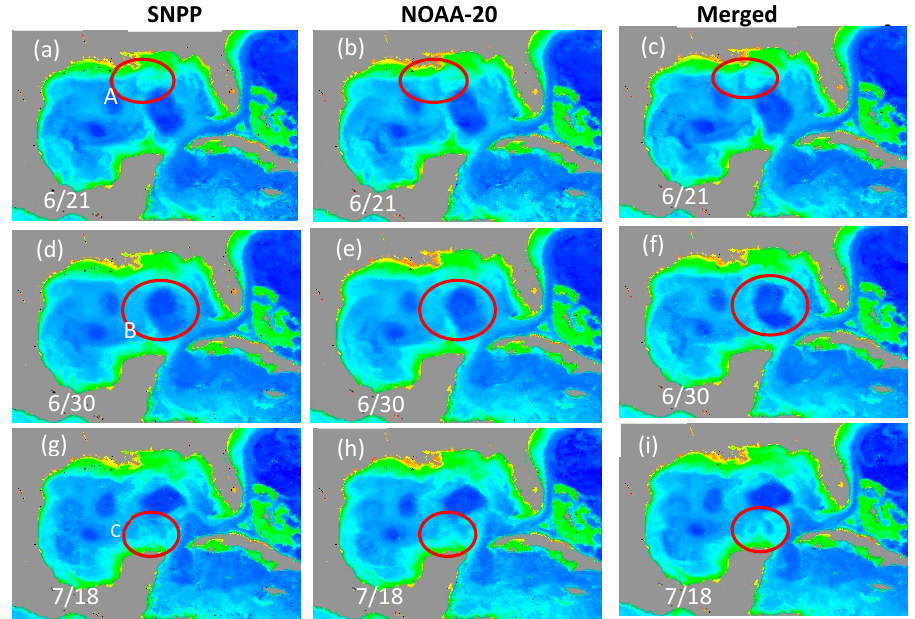
Figure 5. Comparison of the VIIRS-derived ocean features in the GOM in the gap-filled images based on SNPP (left column), NOAA-20 (middle column), and SNPP/NOAA-20 merged (right column) data in 2018 on 21 June (top row) ( a – c ), 30 June (middle row) ( d – f ), and 18 July (bottom row) ( g – i ).